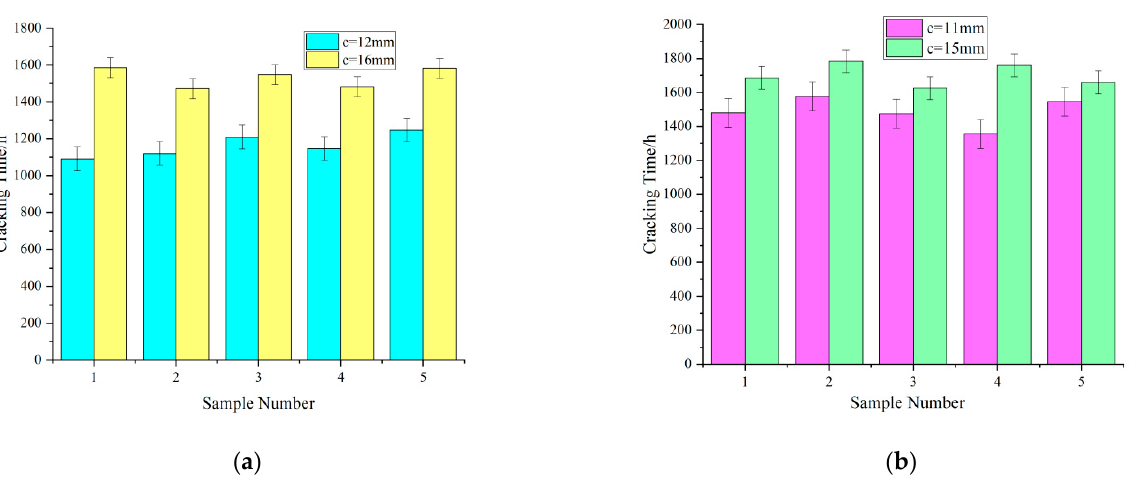
Figure 5. Effect of concrete cover thickness on cracking time. ( a ) Cracking times of samples with different concrete-cover thicknesses ( d = 8 mm), ( b ) Cracking times of samples with different concrete covers ( d = 10 mm).